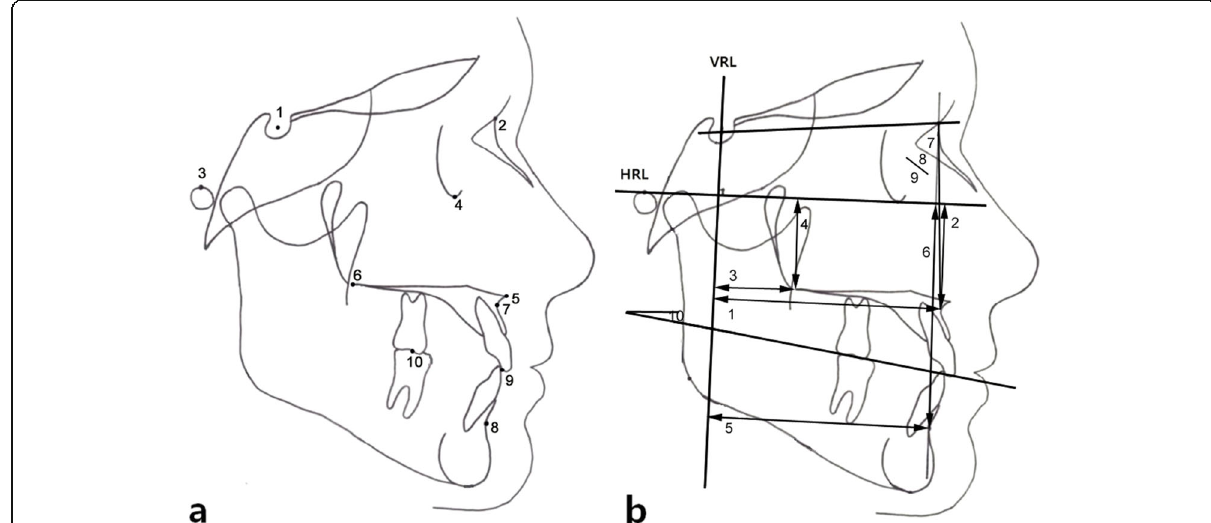
Fig. 1 a Reference points used in this study: 1. Sella (S); 2. Nasion (N); 3. Porion (Po); 4. Orbitale (Or); 5. Anterior nasal spine (ANS); 6. Posterior nasal spine (PNS); 7. Subspinale (A); 8. Supramentale (B); 9. The point bisects the vertical distance between the tips of maxillary (U1) and mandibular central incisor (L1) 10. The point bisects the vertical distance between the occlusal surfaces of maxillary (U6) and mandibular first molar (L6). b Measuring parameters used in this study: 1. VRL-A (mm); 2. HRL-A (mm); 3. VRL-PNS (mm); 4. HRL-PNS (mm); 5. VRL-B (mm); 6. HRL-B (mm); 7. SNA (°); 8. SNB (°); 9. ANB (°); 10. Occlusal plane angle